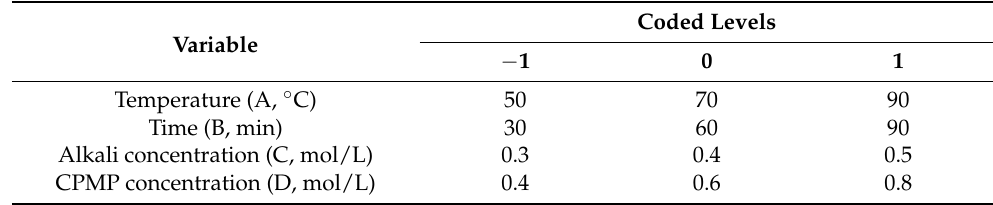
Table 6. Levels and code of derivatization variables used in Box–Behnken